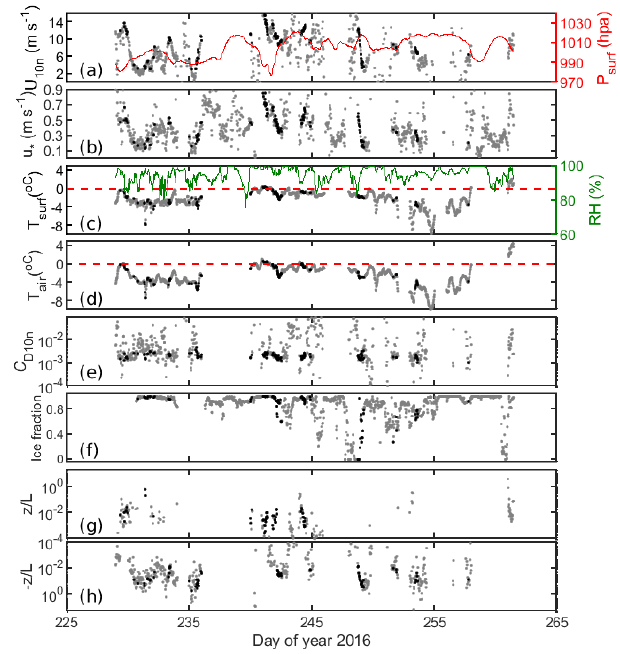
Figure 3. As Fig. 2 but for AO2016.